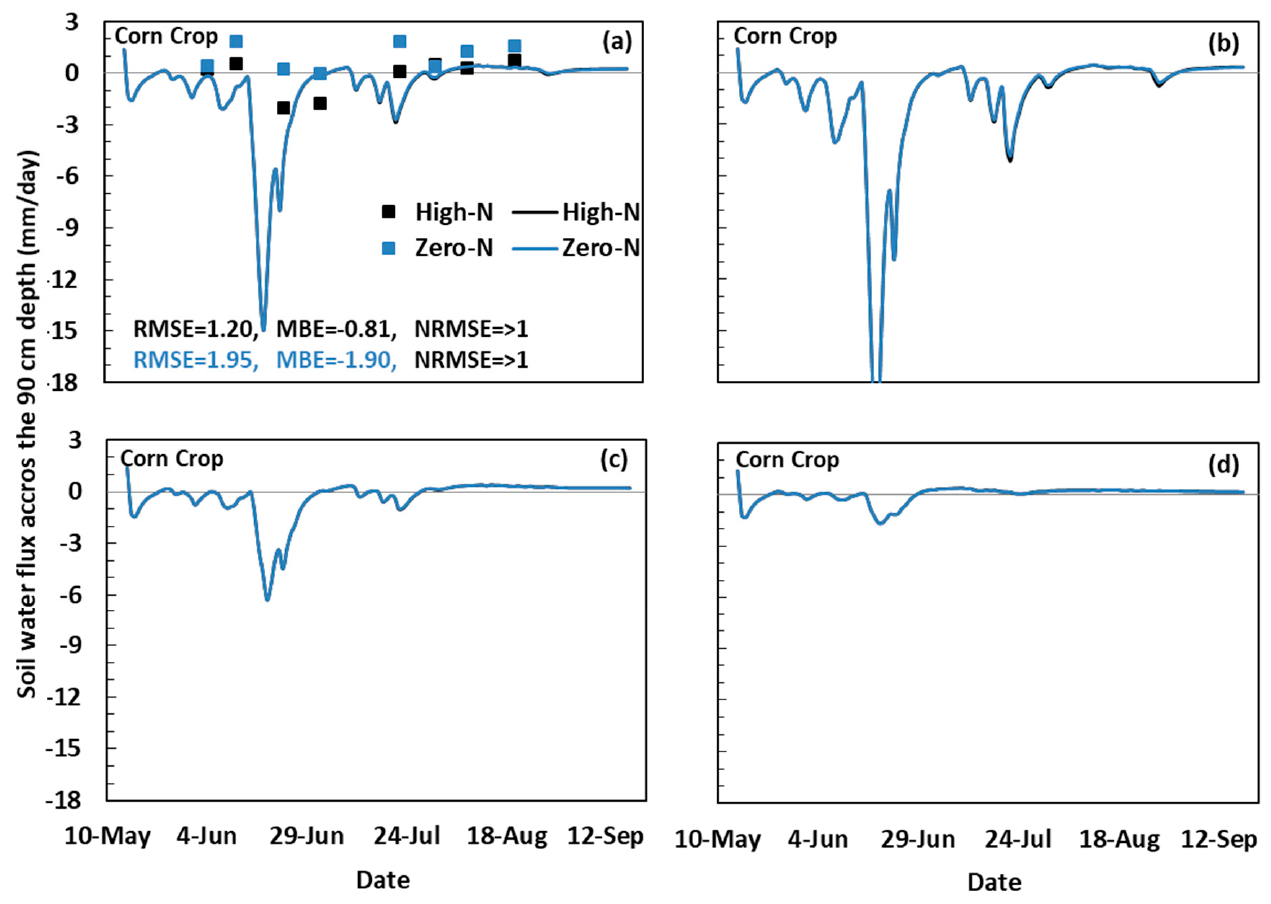
Figure 6. Soil water flux across the 90 cm plane of the root zone for the wheat and corn growing seasons when under the ( a ) 100%, ( b ) 125%, ( c ) 75%, and ( d ) 50% rainfall scenarios.